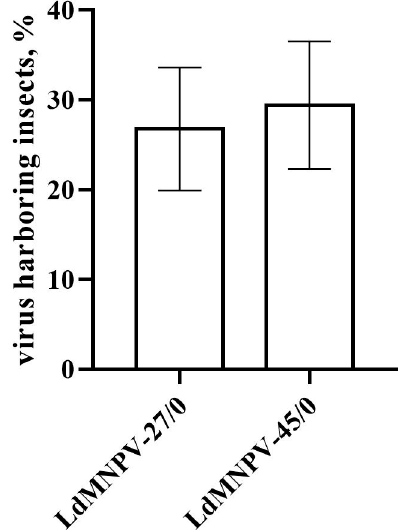
Figure 1. Prevalence of covert viral infection in Lymantria dispar eggs after vertical transmission of low (LdMNPV-27/0) and high (LdMNPV-45/0) virulent strains via one host generations.